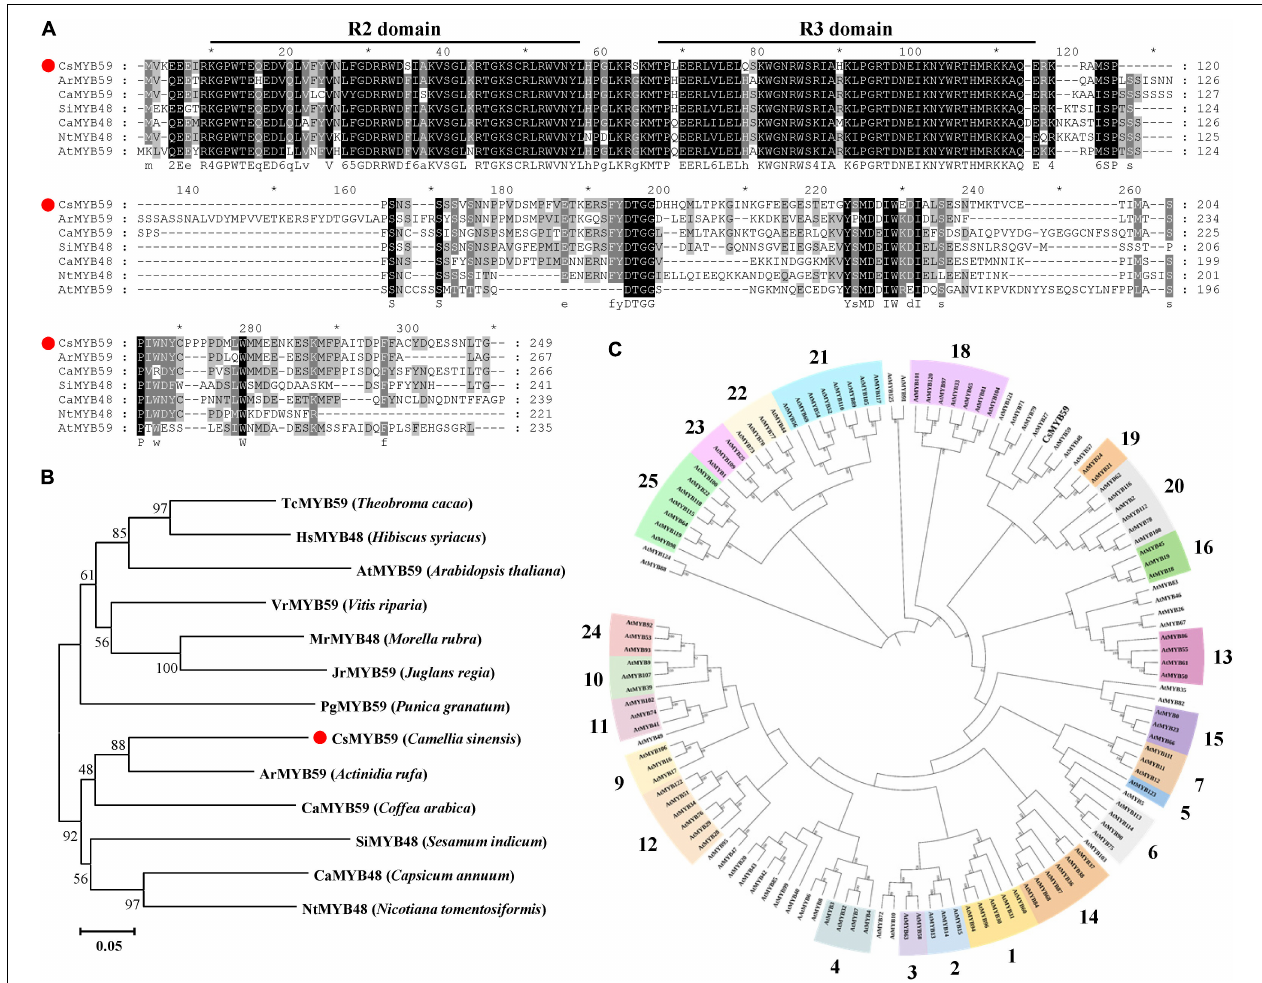
FIGURE 2 | Bioinformatics analysis of the CsMYB59 protein sequence. (A) Protein sequence alignment between CsMYB59 and ArMYB59, CaMYB59, SiMYB48, CaMYB48, NtMYB48, and AtMYB59. (B) Phylogenetic tree generated using sequences of CsMYB59 and homologous MYB transcription factors of 12 other plant species; CsMYB59 is labeled with a red dot. The plants are specified in the brackets. The accession numbers of the protein sequences are as follows: TcMYB59 (EOY34142.1), HsMYB48 (XP_038991988.1), AtMYB59 (Q4JL84.2), VrMYB59 (XP_034687869.1), MrMYB48 (KAB1226039.1), JrMYB59 (XP_035545886.1), PgMYB59 (XP_031387608.1), ArMYB59 (GFS42876.1), CaMYB59 (XP_027108891.1), SiMYB48 (XP_011089426.1), CaMYB48 (KAF3662000.1), and NtMYB48 (XP_009590049.1). (C) Phylogenetic analysis of CsMYB59 and Arabidopsis -derived R2R3-MYB sequence. The bold numerals represent subgroups of R2R3-MYB TFs in A. thaliana . *means positions that have a single, fully conserved residue. CsMYB59 is marked with a red